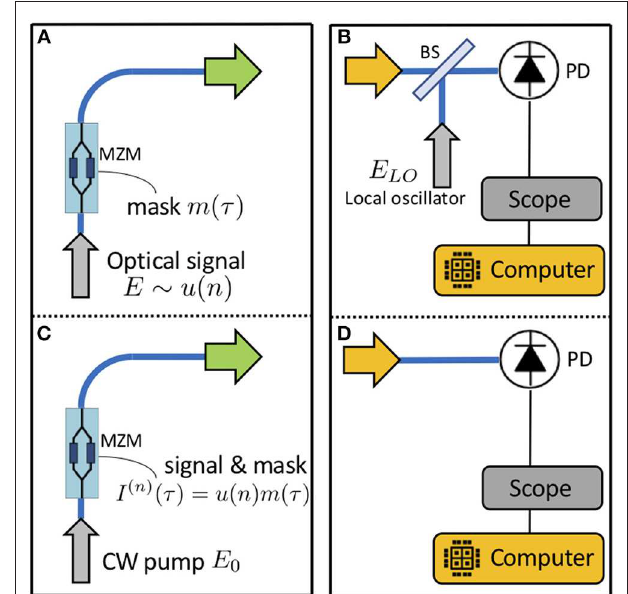
layer (through the orange arrow) where the neural responses are demultiplexed. FIGURE 2 | Schematics of input and output layers connecting to the reservoir